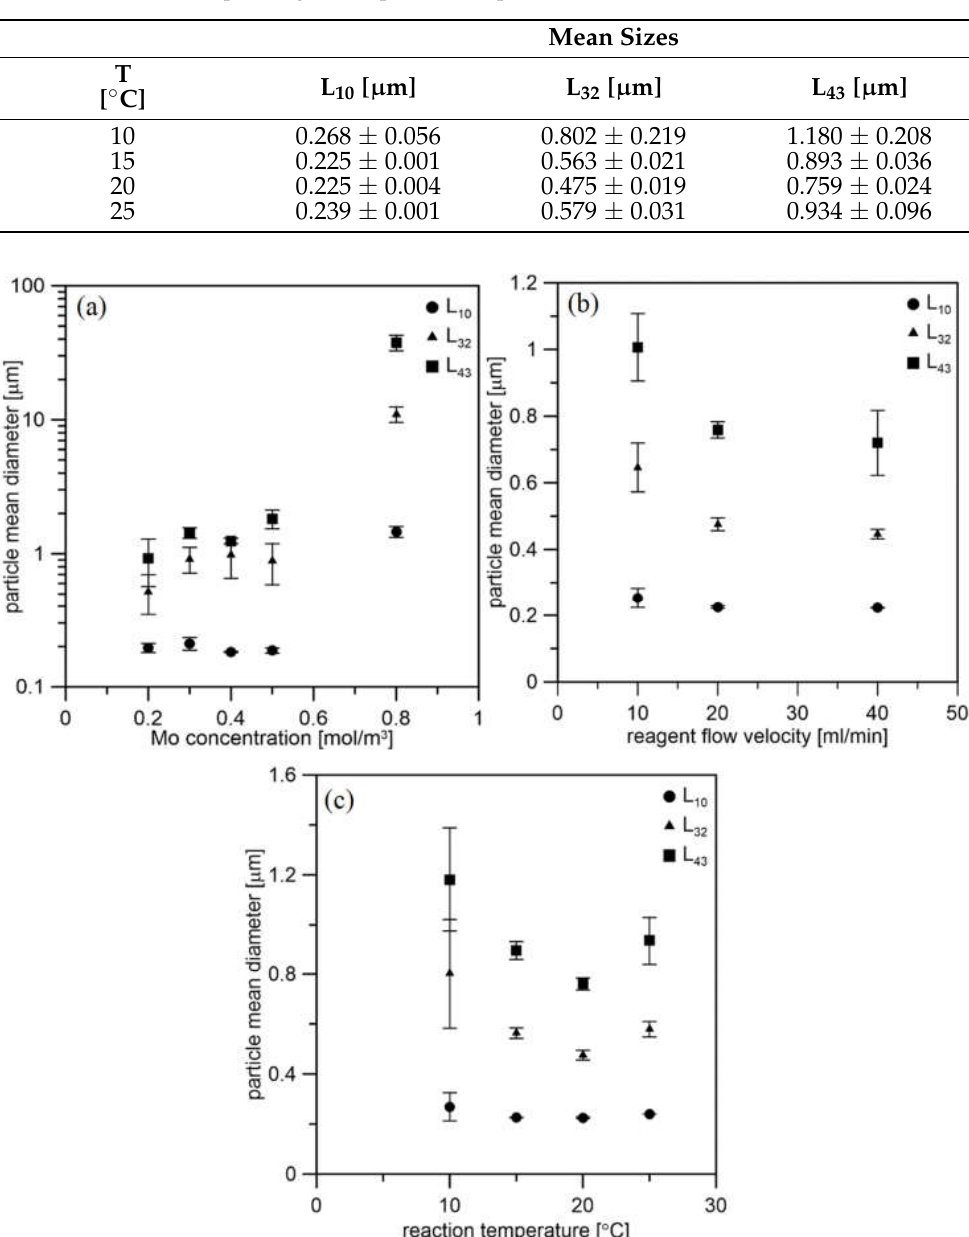
Table 5. Mean sizes depending on the process temperature.